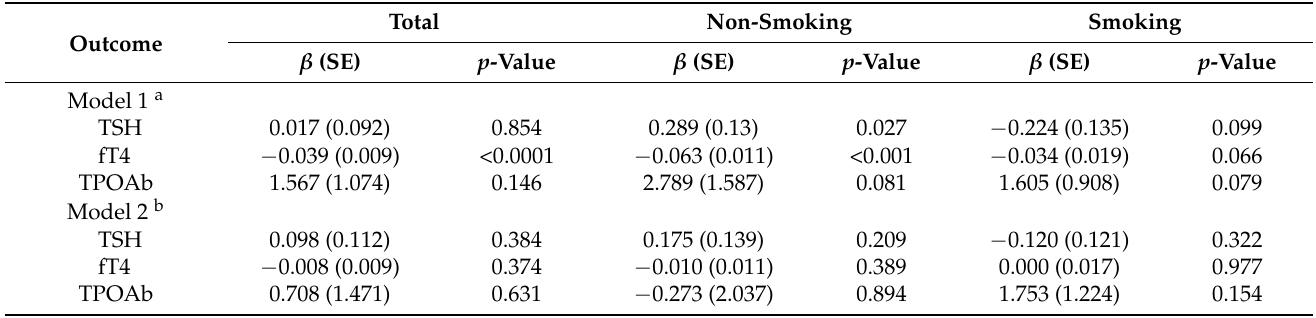
Table 4. Associations between the Cd Concentration (log Transformed) and thyroid